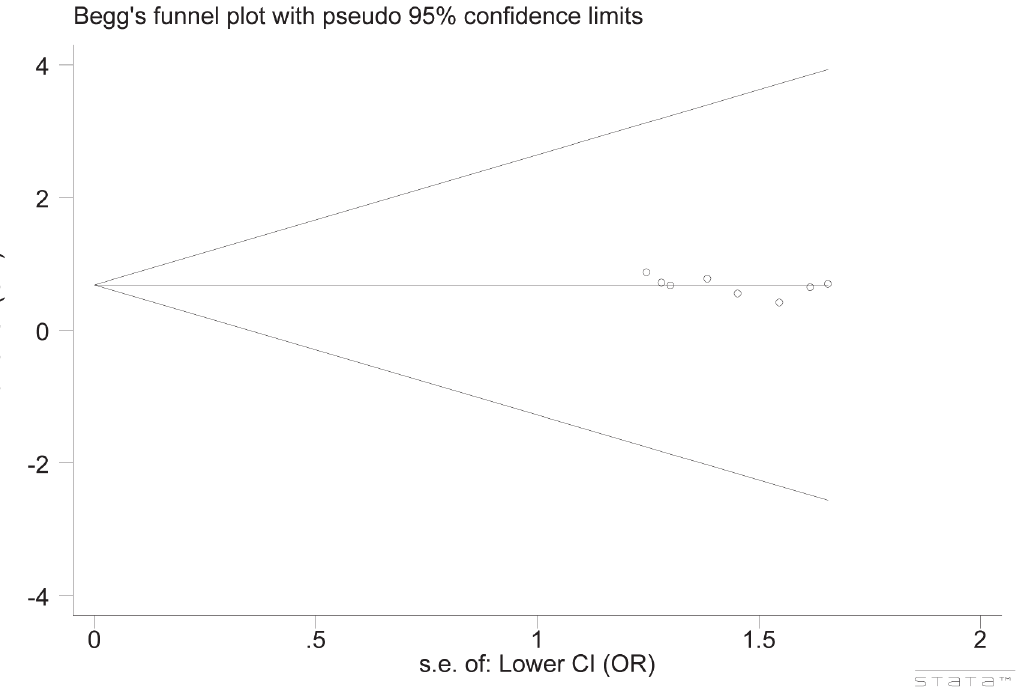
Fig 3. Funnel plot analysis to detect publication bias. Each point represents an individual study for the indicated association. No publication bias was suggested in this meta-analysis (Arg/Arg vs.